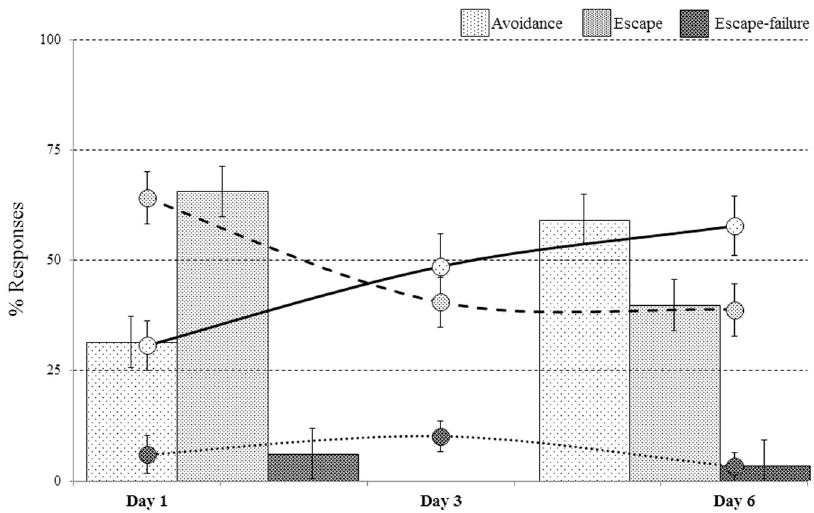
Figure 1. Performances in the ‘TWSA’ task: over the 6 days of training, controllable animals exhibited an increase in avoidance responses and a reduction in their escape responses. This demonstrates the rats’ ability to control the appearance of the US ( * > 0.05, ** >